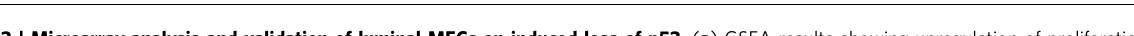
Figure 3 | Microarray analysis and validation of luminal MECs on induced loss of p53. ( a ) GSEA results showing upregulation of proliferation-related (grey-shaded) and FOXA1 (HNF3A)-related (red-shaded) gene sets from the H (Hallmark), C2 (canonical pathways) and C5 (Gene Ontology (GO) terms) collections of the GSEA MSigDB v5.2 in YFP þ Trp53 -null MECs from K8-CreER;Trp53 L/L ;R26Y females ( n ¼ 4) compared with YFP þ WT MECs from K8-CreER;R26Y females ( n ¼ 3), 4 weeks after tamoxifen induction. ( b ) GSEA results showing downregulation of immune (grey-shaded), hypoxia (green-shaded), p53 pathway/targets (purple-shaded) and apoptosis (blue-shaded)-related gene sets in YFP þ Trp53 -null MECs. In a , b normalized enrichment score (NES) and nominal P value (NOM p-val ) are shown for each gene set. ( c ) Percentages of Ki67 þ cells among YFP-marked MECs in Trp53 L/L ;R26Y females (p53, n ¼ 3) or R26Y -only females (WT, n ¼ 3) 3–4 weeks after Ad-K8-Cre injection. Representative YFP/Ki67 co-staining pictures are shown in Supplementary Fig. 1b. At least 10 ducts per section were counted. Data represent mean ± s.e.m. ( d ) Heatmap showing expression levels of select genes in different categories in YFP þ Trp53 -null MECs compared with matched YFP þ WT MECs. For each gene, the expression value from each sample was normalized to the mean of WTsamples ( ¼ 1) and the resulted relative expression value (that is, fold change to the mean of WT) was shown on the heatmap. ( e ) GSEA result showing significant enrichment of an ER þ mature luminal cell gene set (from ref. 36) in Trp53 -null MECs in relation to WT controls. NES and nominal P value are shown. ( f ) Representative co-IF pictures showing YFP (green) and ER a (red) staining for MGs from Trp53 L/L ;R26Y females (p53, n ¼ 4) or R26Y -only females (WT, n ¼ 4) 3–4 weeks after Ad-K8-Cre injection. An YFP þ multi-cell clone comprised of two ER þ cells and one ER (cid:2) cells is highlighted. Individual YFP þ ER þ cells are indicated by red arrows. Scale bars, 20 m